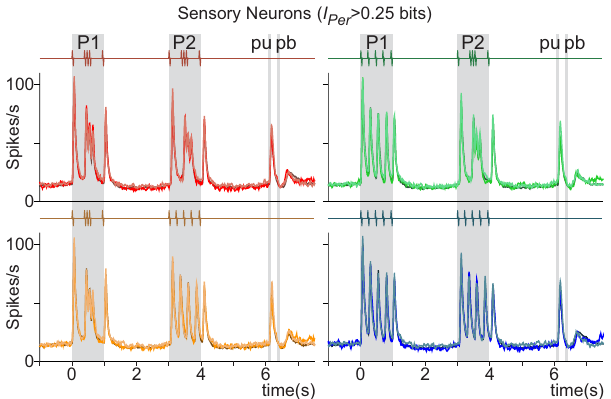
Fig. 5 Sensory responses during hit, error, and LCT trials. Sensory S2 neurons selected with signi fi cant periodicity information >0.25bits ( I Per > 0.25bits, Eq. (10)). Superimposed normalized S2 sensory population activity for hit (dark traces), error ( n = 105, mid-tone traces), and LCT trials ( n = 41, light traces). Each color refers to one class: G-G (red); G-E (orange); E-G (green); and E-E (blue). Even if the number of neurons is the same for hit and error responses, the number of error trials is far fewer. Differences between responses associated with each class, calculated using integral square error, were found to be small (from 1.2 to 2.6%). Normalized LCT activity included all trials, since animals have no errors during this control (see extended version in Supplementary Fig. 9).